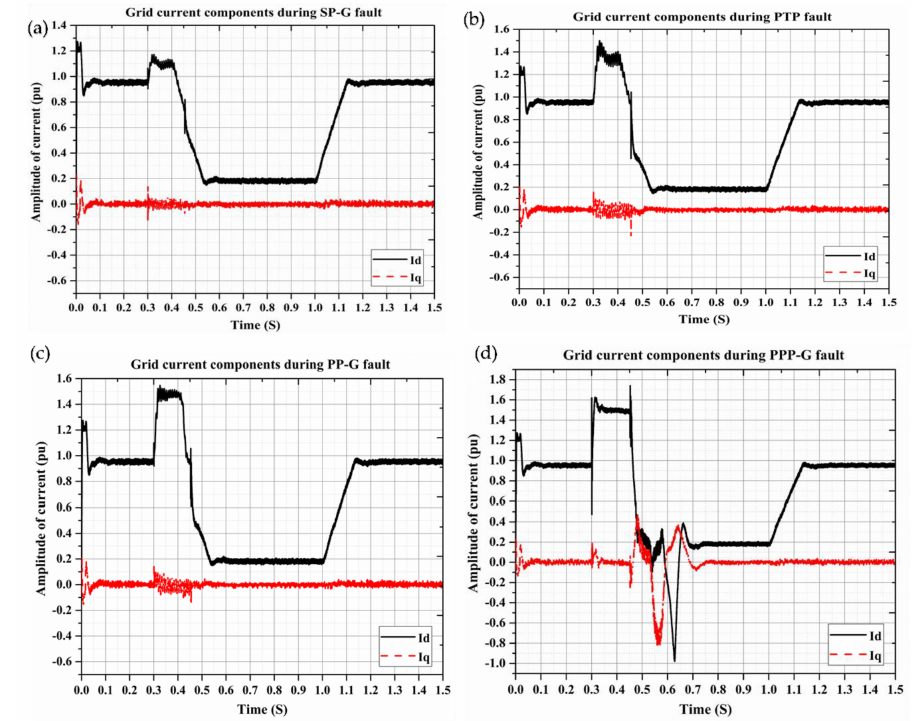
Figure 8. ( a – d ) The Id and Iq grid current components during grid faults.